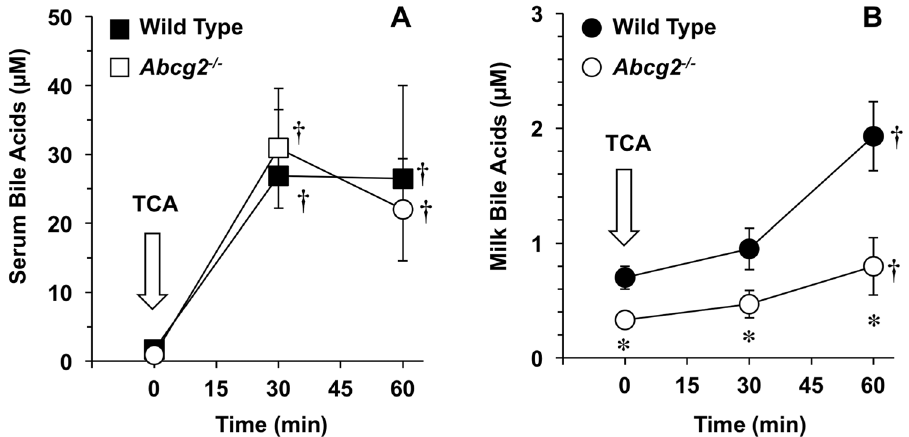
Figure 5. Bile acid concentrations as determined by HPLC-MS/MS in paired samples of serum ( A ) and milk ( B ) collected from lactating wild-type and Abcg2 − / − mice on day 10 after delivery. At min 0 the animals received (i.p.) 5 µ mol taurocholic acid (TCA). Owing to the impossibility of repeated sampling from the same mice, blood and milk samples were collected at min 0, 30 or 60 after TCA administration in different sets of animals (n = 5 per group). Values are means ± SEM. * p < 0.05, comparing wild-type and Abcg2 − / − mice. † p < 0.05, compared with basal values before TCA administration. Bonferroni method of multiple-range testing was used for